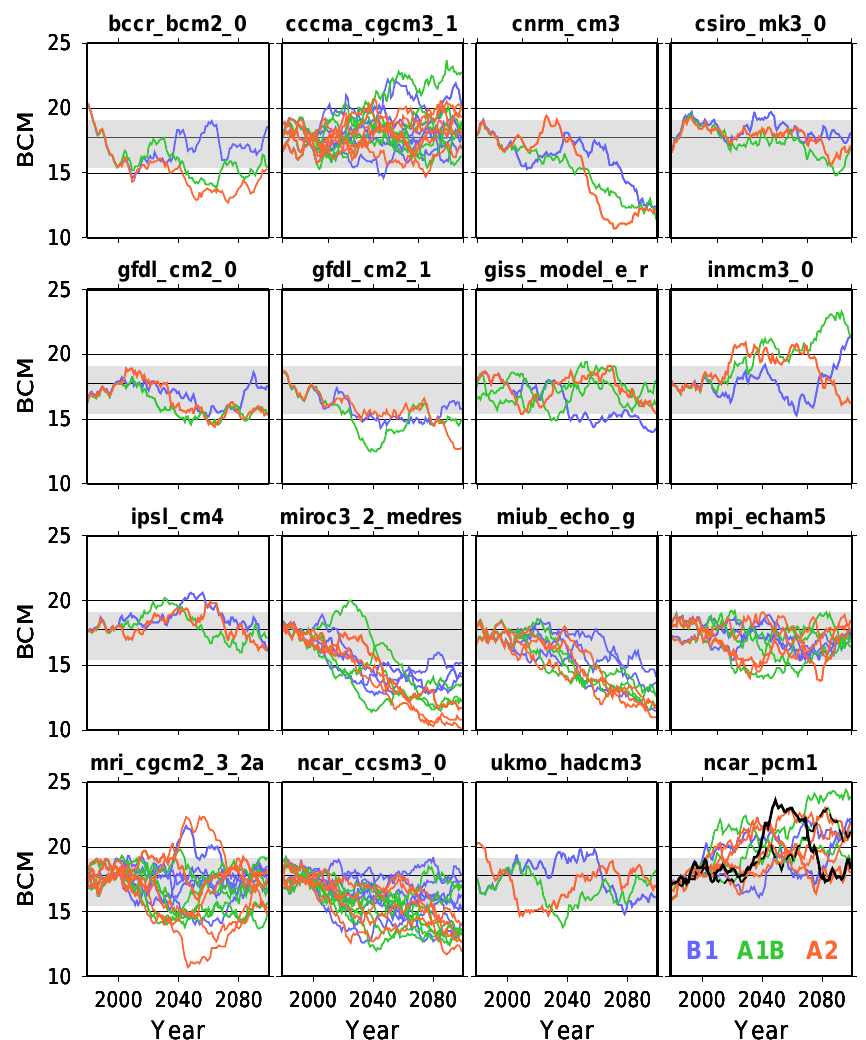
Fig. 8. Time evolution of projected 30-yr averages (trailing) of annual Colorado River streamflow at Lees Ferry, AZ. Projections are color- coded by emissions pathway (see bottom right panel), with the exception of two runs that are highlighted for the NCAR PCM1 model (see